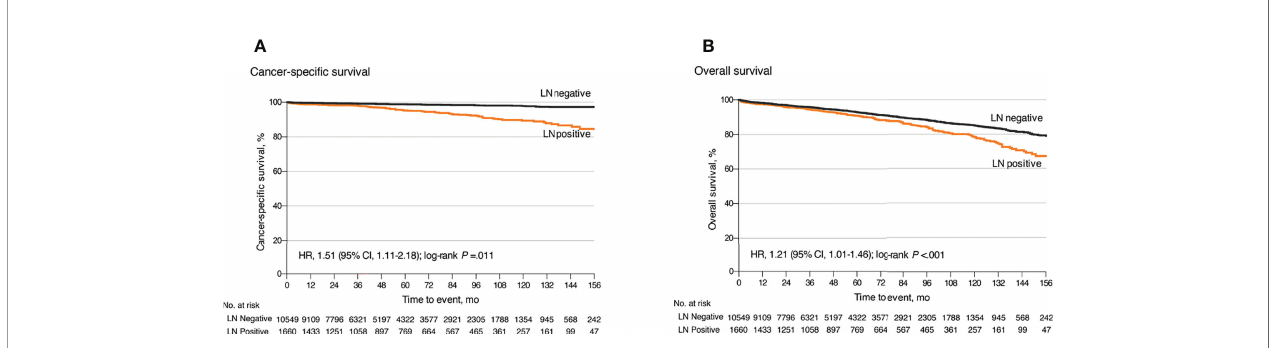
FIGURE 1 | Kaplan – Meier curves for cancer-speci fi c and overall survival for all patients with small well-differentiated GEP-NETs strati fi ed by LN status. (A) Kaplan – Meier analysis of cancer-speci fi c survival. (B) Kaplan – Meier analysis of overall survival. GEP-NETs, gastroenteropancreatic neuroendocrine tumors; LN, lymph